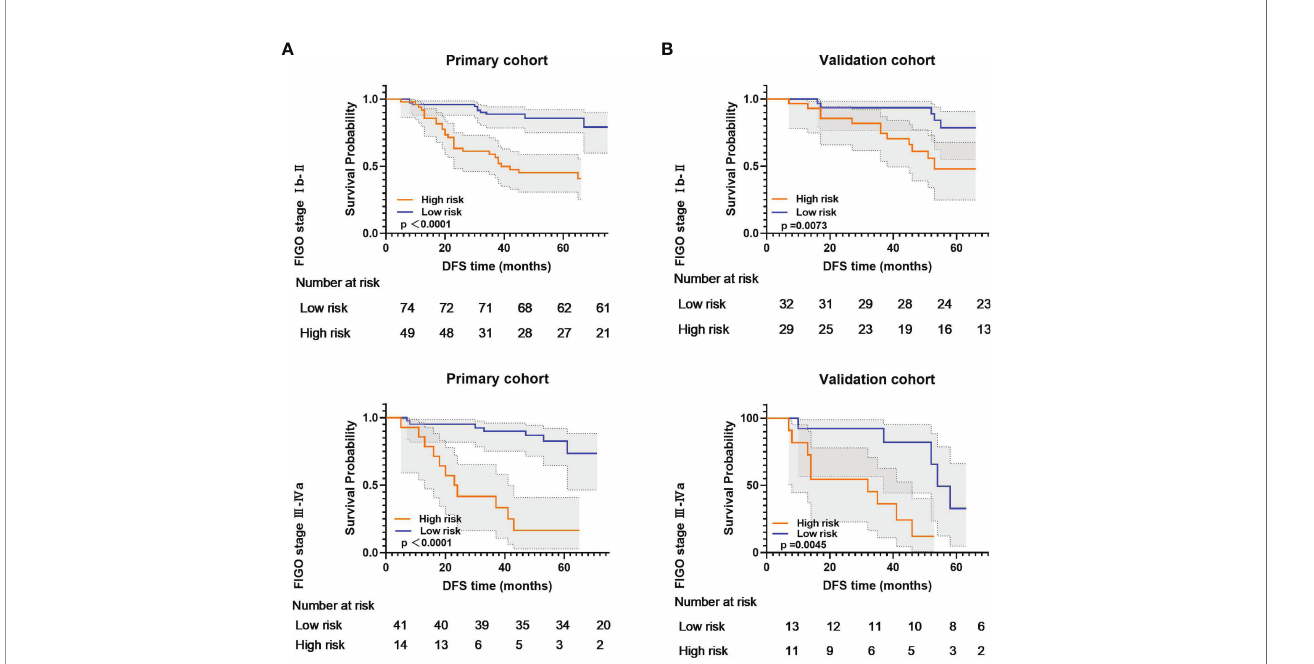
FIGURE 5 | Kaplan-Meier analysis according to the radiomic signature among locally advanced cervical cancer patient subgroups in (A) primary cohort and (B) validation